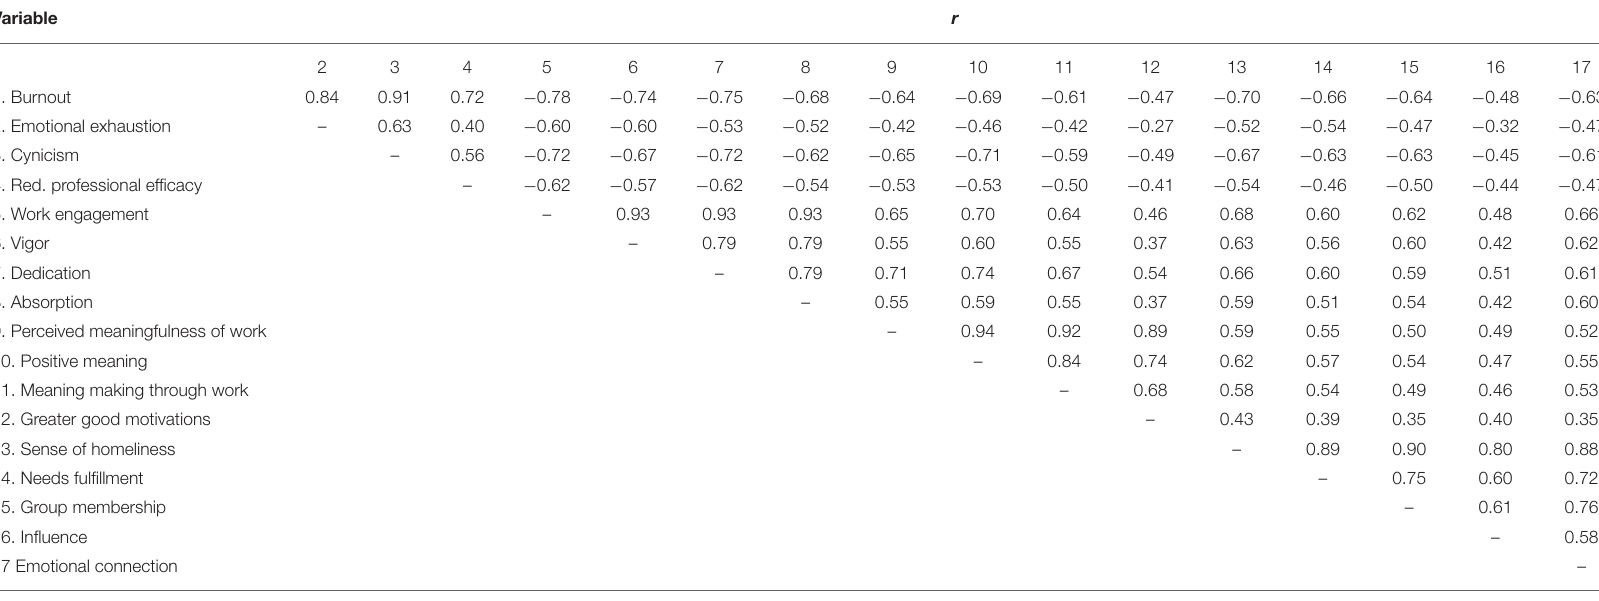
TABLE 3 | Pearson correlations between the study variables.